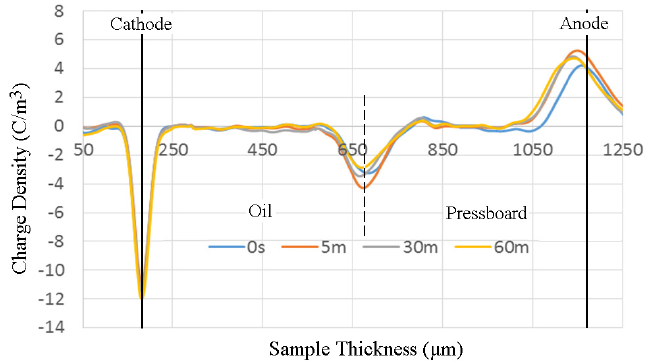
Figure 28. Volt ‐ on results of space charge in fresh oil combined with impregnated pressboard insulation system under AC/DC combined stresses at 81°.